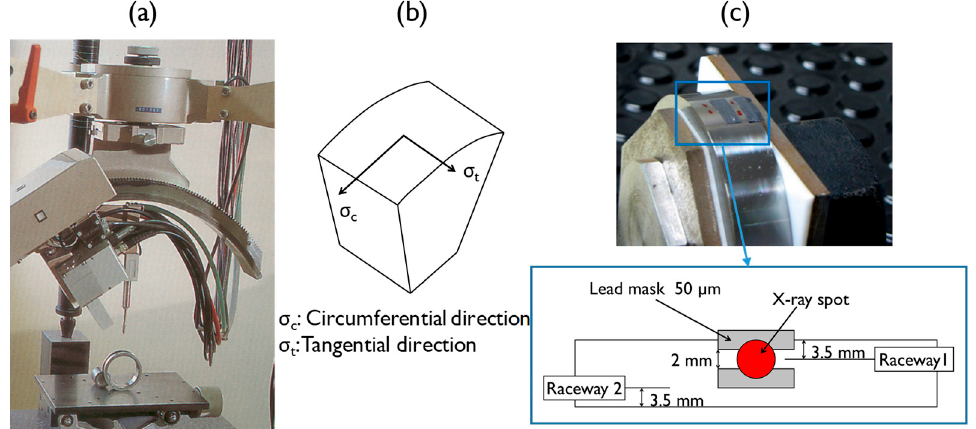
Figure 3. ( a ) Setup for the residual stress measurements; ( b ) residual stress measurement directions; ( c ) limiting device of X-ray beam with the raceway width.